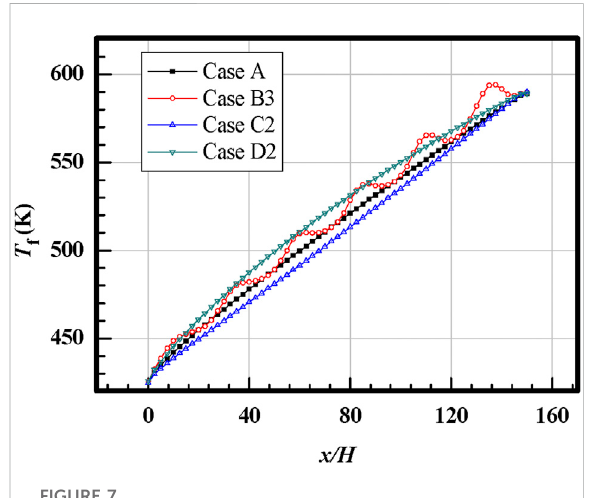
FIGURE 7 Fluid temperature distributions along the streamwise direction for cases loaded with different heat fl ux